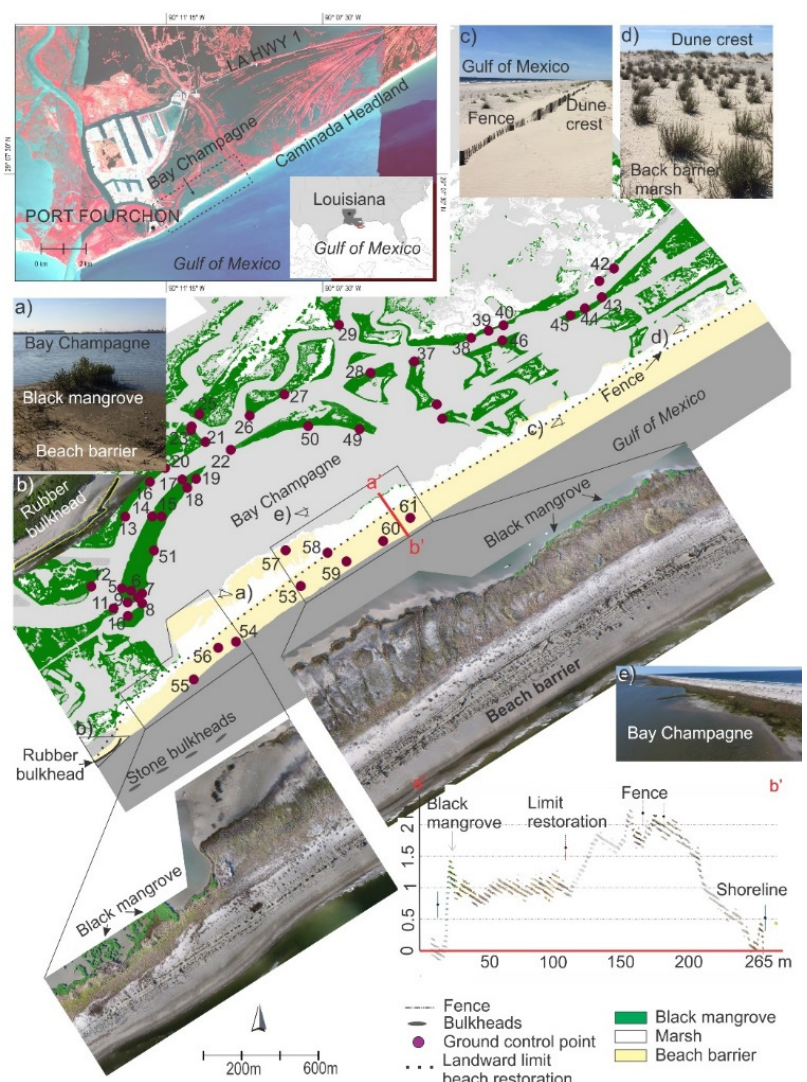
Figure 1. Location of the study area in the Bay Champagne, Louisiana, with limits of black mangrove and marshes, ground control points indicated and a planialtimetric cross-shore profile (a’—b’). ( a ) Ground photo taken in Nov/2019 exhibiting establishment of Avicennia shrubs on backbarrier tidal flats; ( b ) aerial photo taken in Mar/2018 showing the rubber bulkheads; ( c ) ground photo taken in Nov/2019 showing the fence on beach barrier; ( d ) ground photo taken in Nov/2019 showing herbaceous vegetation on backbarrier sandy plain; ( e ) aerial photos obtained in Nov/2019 showing the beach barrier.